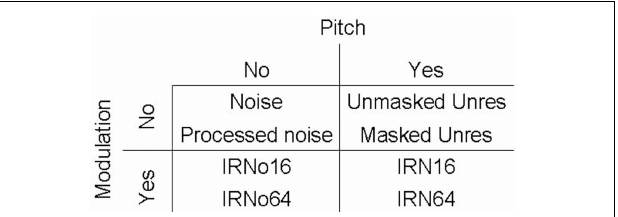
FIGURE 2 | Schematic representation of the continuous stimulation paradigm used for presentation of stimuli in the MR scanner. The 10-ms ramps of the two sounds in each sequence were overlapped at the 3dB SPL point (at 5ms) to produce a stable envelope.